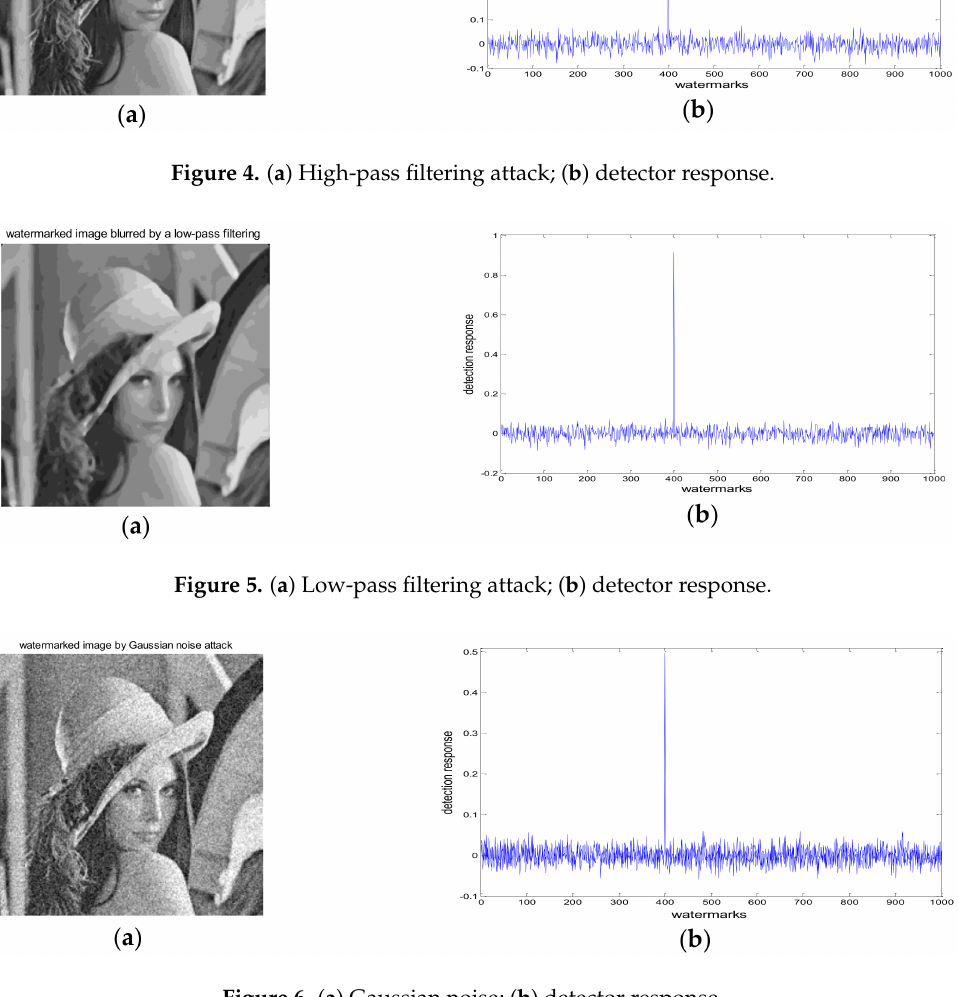
Figure 6. ( a ) Gaussian noise; ( b ) detector